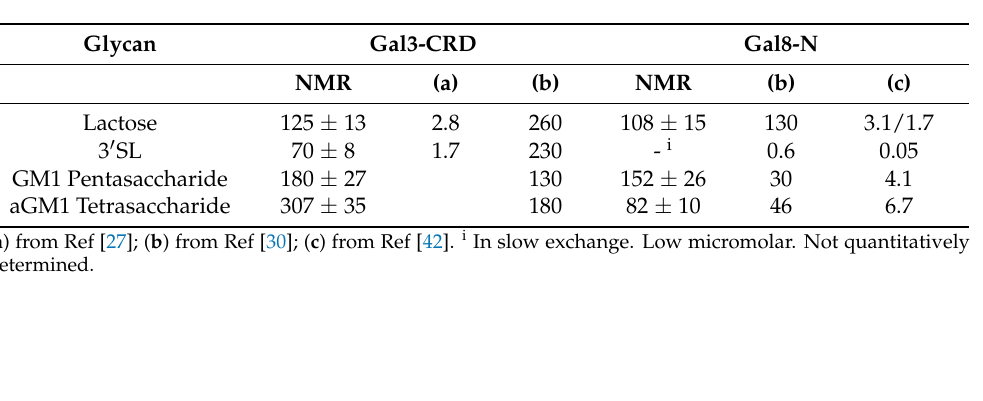
Figure 1. 1 H-STD-NMR and corresponding reference spectra for the interaction of glycans ( a ) 3 ′ SL, ( b ) GM1 pentasaccharide, and ( c ) aGM1 tetrasaccharide with Gal-3 full length, and schematic representation of the STD NMR-based glycan binding epitopes (below): a solid curve indicates main binding epitope, and a dashed curve indicates additional minor contacts with the protein. Residues showing no STD NMR signals are far from the protein surface. The asterisk indicates and impurity (EtOH). Table 1. Dissociation constant values (K D ) ( µ M) for the interaction of Gal3 and Gal8N with lactose, 3 (cid:48) SL, and GM1 pentasaccharide and aGM1 tetrasaccharide estimated from 1 H, 15 N-HSQC titrations. Data from the literature are also